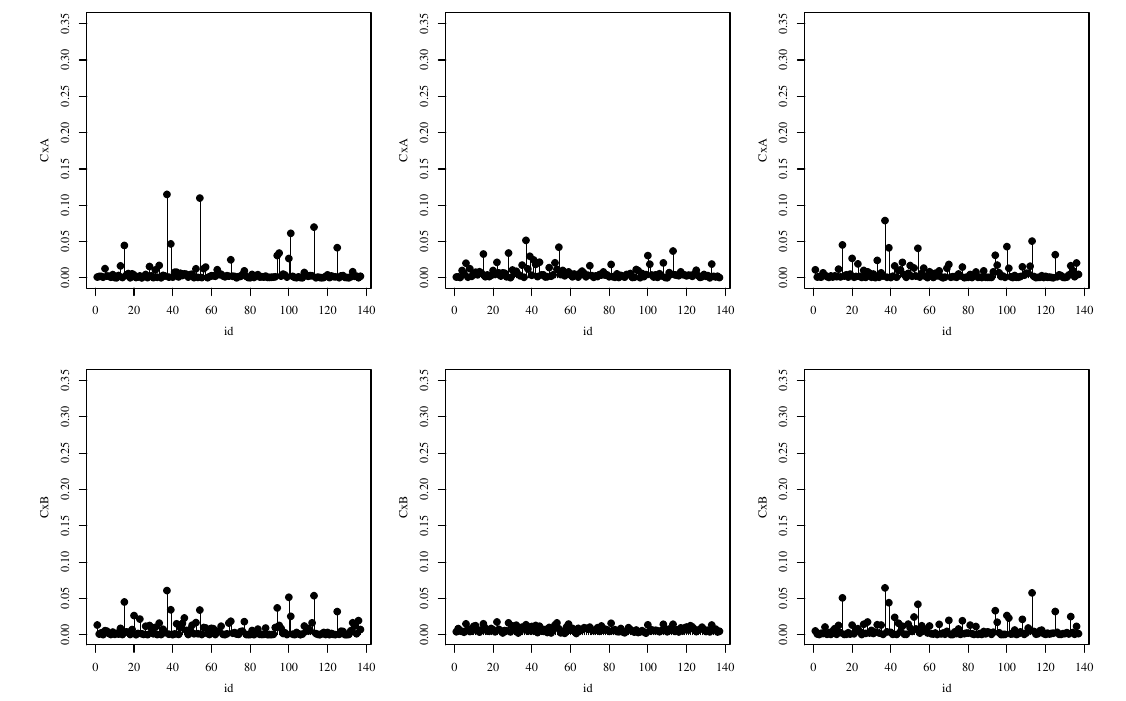
Figure A1. The index plots of C i for (cid:98) β ( upper ) and (cid:98) ν ( lower ) under the weight perturbation ( left ), response perturbation ( center ), and covariate perturbation ( right ) schemes for the RPGJSB2 q model with q = 0.1 (link loglog and G the cdf from the normal model) of the COVID-19 data